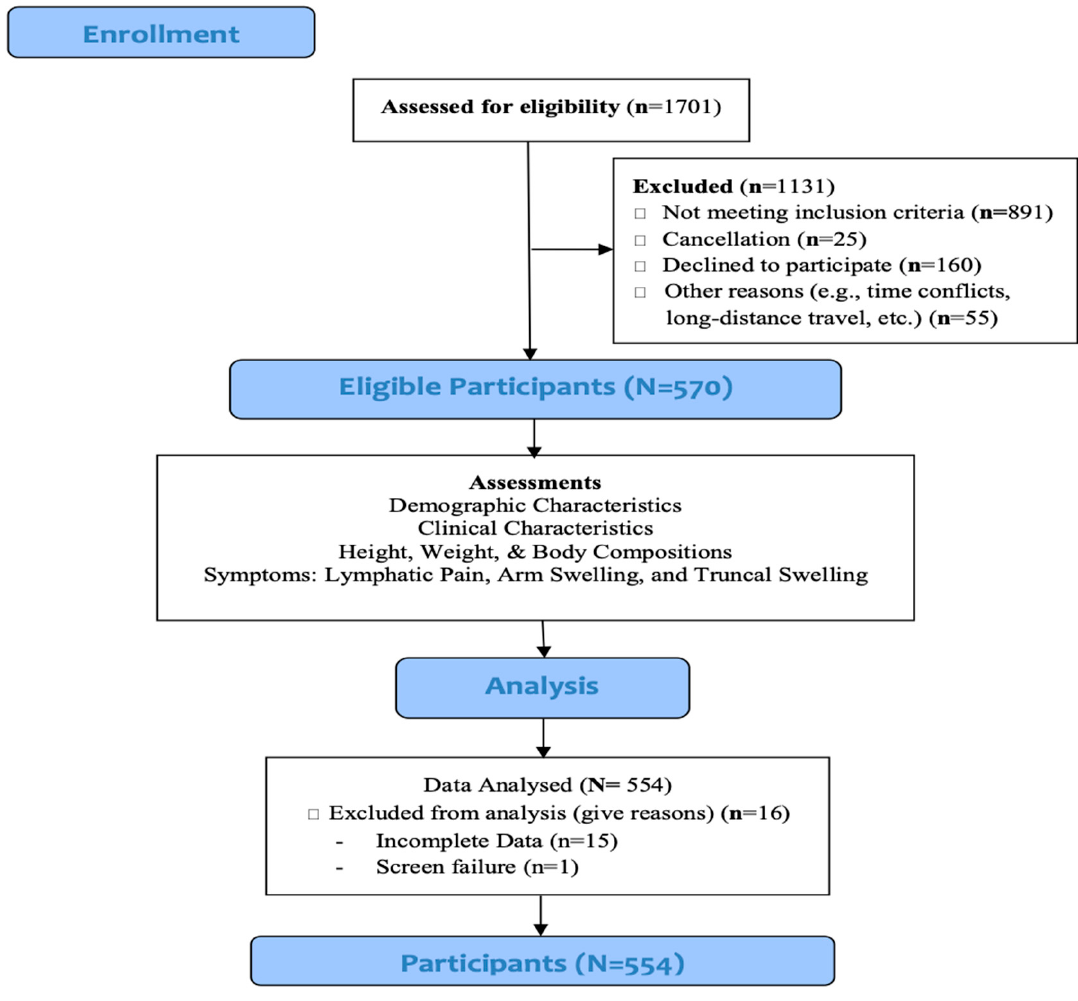
Figure 1. Patient